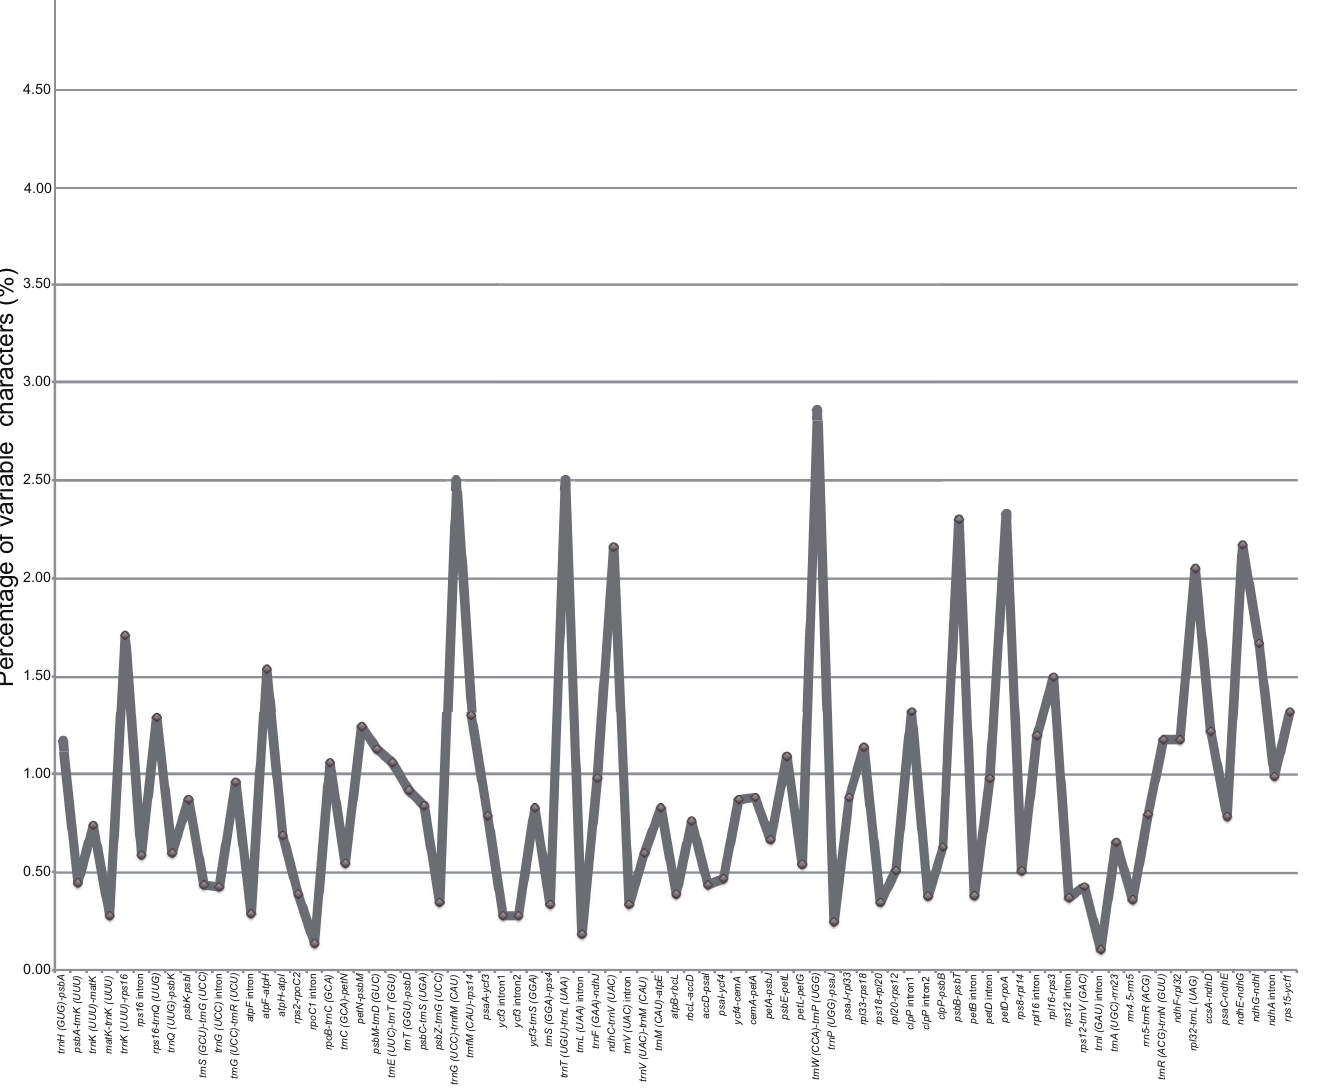
PLOS ONE | https://doi.org/10.1371/journal.pone.0178026 June 2,